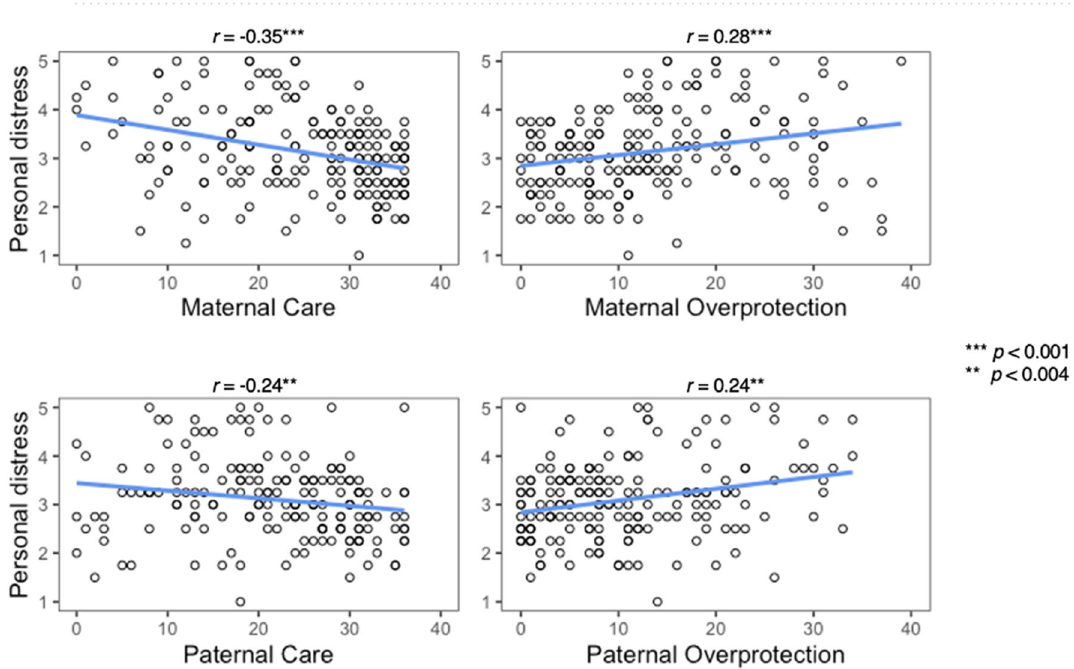
Figure 2. Association between PBI (= parental bonding instrument) subscales and personal distress in response to others’